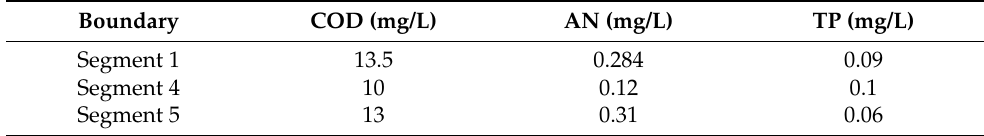
Table 5. Determination of initial boundary